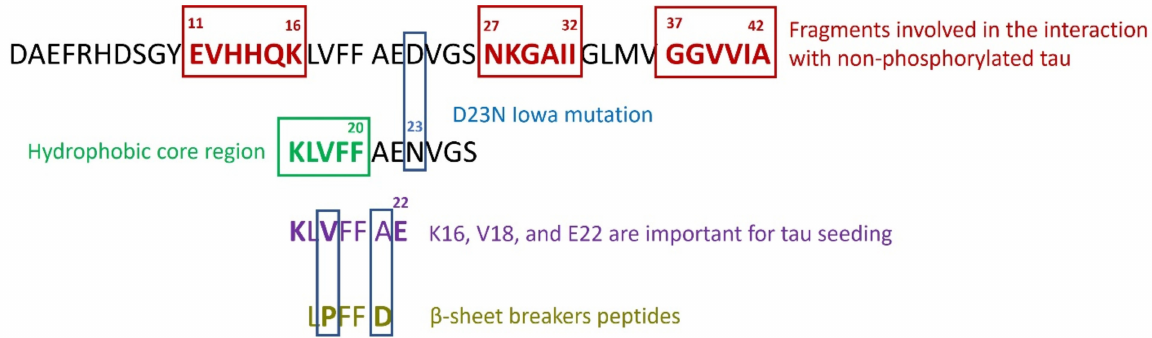
Figure 3. A β 1–42: fragments involved in the interaction with non-phosphorylated tau: EVHHQK (residues 11–16), NKGAII (residues 27–32), and GGVVIA (residues 37–42) [142]; the hydrophobic core region (KLVFF) [148,169] and the β -sheet breaker peptide LPFFD [149].